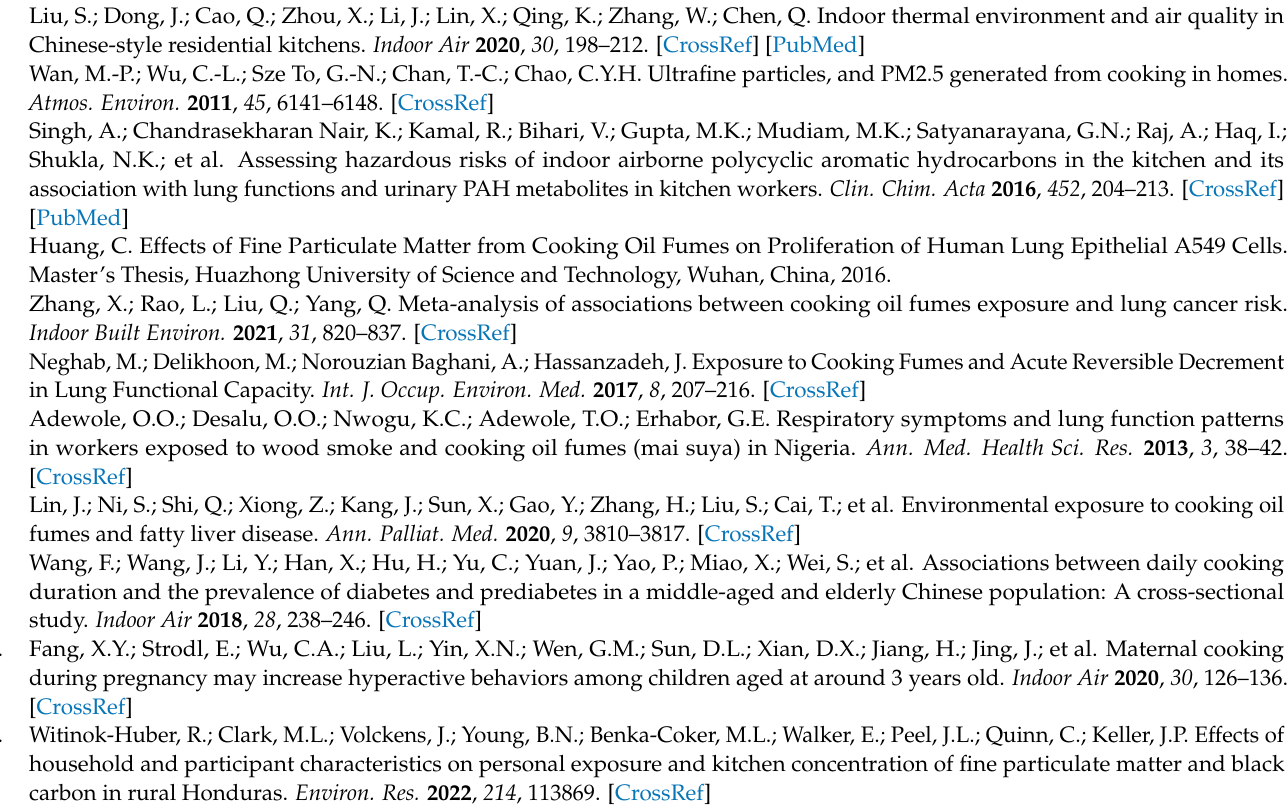
gions. Figure S2: Statistical analysis of the influence of COF condensates in different regions on α -glucosidase activity. Figure S3: Statistical analysis of the influence of COF condensates in differ- ent regions on AchE activity. Figure S4: Statistical analysis of the influence of COF condensates in different regions on LDH activity. Table S1: Saturated VOCs detected from oil fume conden- sates in seven regions. Table S2: Unsaturated VOCs detected from oil fume condensates in seven regions. Table S3: Heterocyclic compounds, halides, and benzene series detected from oil fume condensates in seven regions. Table S4: The same compounds in the northern and southern regions. Table S5: Different compounds in the northern and southern regions. Table S6: Relative content of compounds in the northern and southern regions. Table S7: The same compounds in the south- east (M-region + S-region) and southwest (C-region + G-region) regions. Table S8: The different compounds in the southeast (M-region+S-region) and southwest (C-region + G-region) regions. Table S9: Compounds in the northern